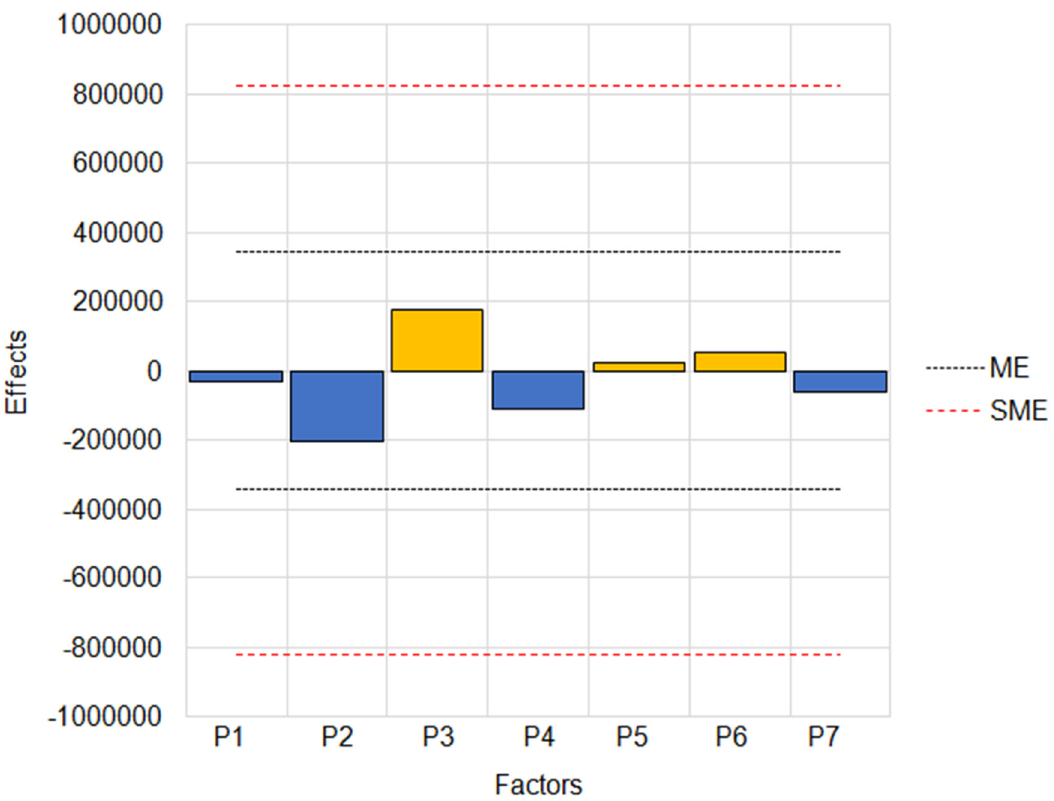
Figure 6. Lenth’s graphic to assess the robustness of the method developed based on previously optimized Si3Py + Cl − -DPX procedure.